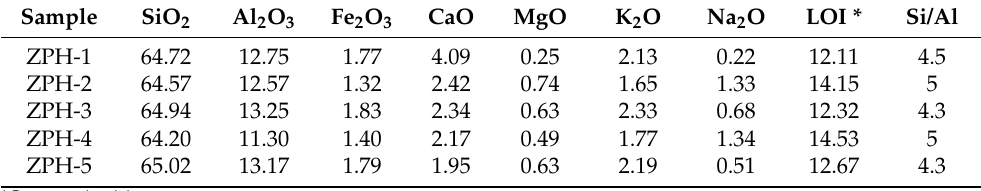
Figure 2. X-ray diffraction patterns of the natural mordenite–clinoptilolite from the research area. Table 1. Chemical composition of the zeolite from the area of research (analysis by XRF + A.